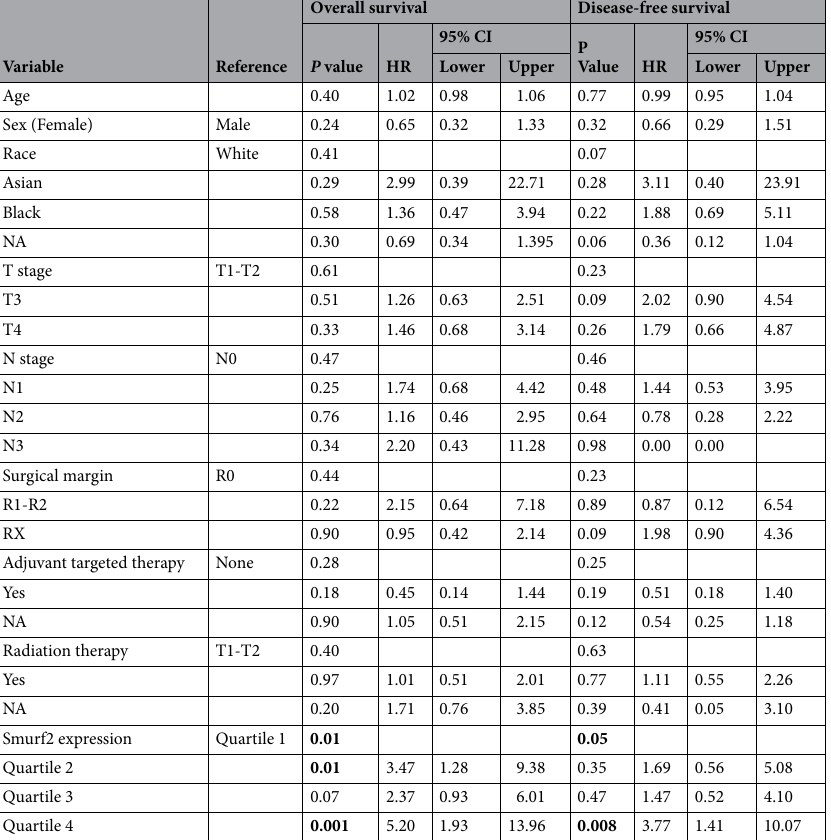
Table 1. Overall and disease-free survival in patients with stage III squamous NSCLC. R0, R1, R2, and RX surgical margins: no microscopic residual tumor, microscopic residual tumor, macroscopic residual tumor, and unknown residual tumor status, respectively. HR: hazard ratio. CI: confidence interval. NA: not applicable. Bold text indicates statistical significance.